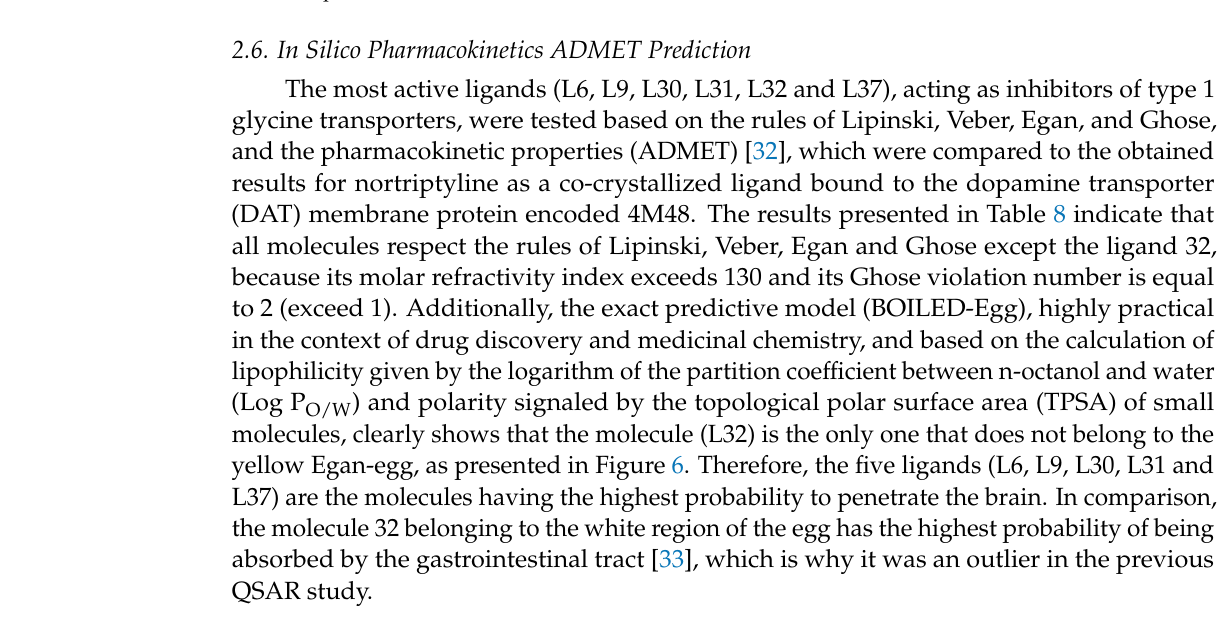
Table 8. Prediction of the physicochemical properties of nortriptyline and more active ligands, based on Lipinski, Veber, Egan and Ghose